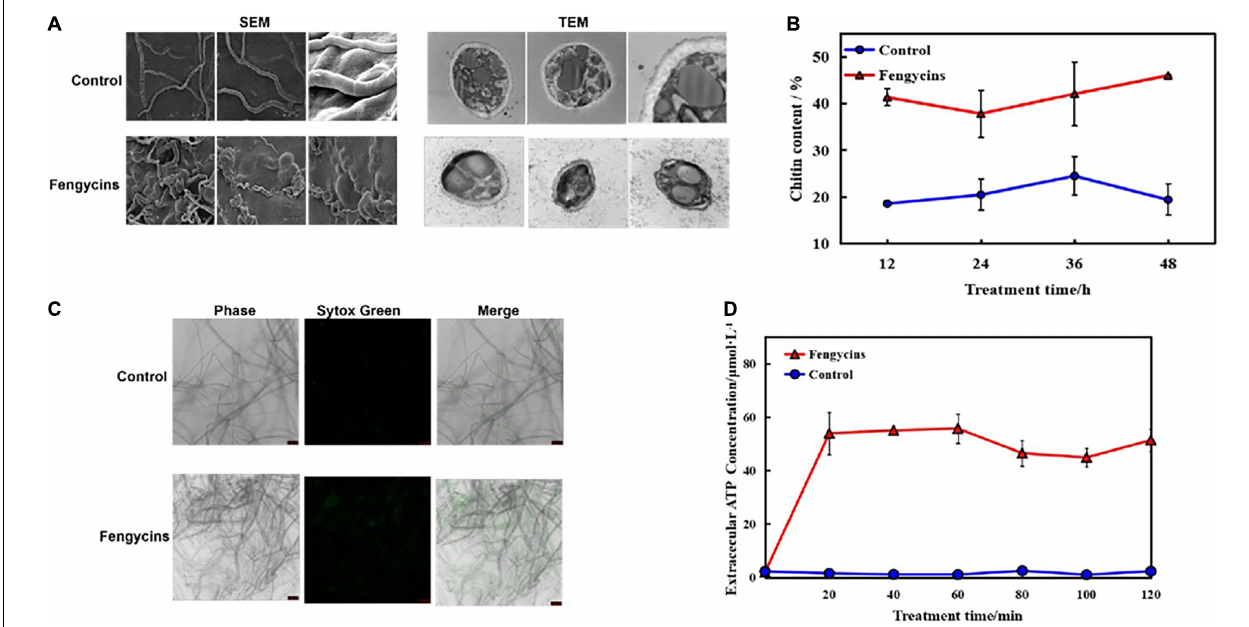
FIGURE 6 | Effects of fengycins on A. solani hyphal cell wall integrity and cell membrane permeability. (A) Scanning and transmission electron micrographs of A. solani hyphae co-cultured with fengycins. (B) Chitin contents of A. solani hyphae co-cultured with fengycins and a control groups. (C) Fluorescence microscope imaging of A. solani hyphae treated with fengycins and a control groups. The phase channel shows all the fungal cells in bright-field images, and the Sytox Green channel shows cells attached or inserted with Sytox Green labeling; the merged channel shows the proportion of Sytox Green-labeled cells. (D) Effects of fengycins on ATP release from A. solani . The changes in the extracellular ATP levels of A. solani represent cell membrane damage. The results are presented as the means ± SDs ( n =